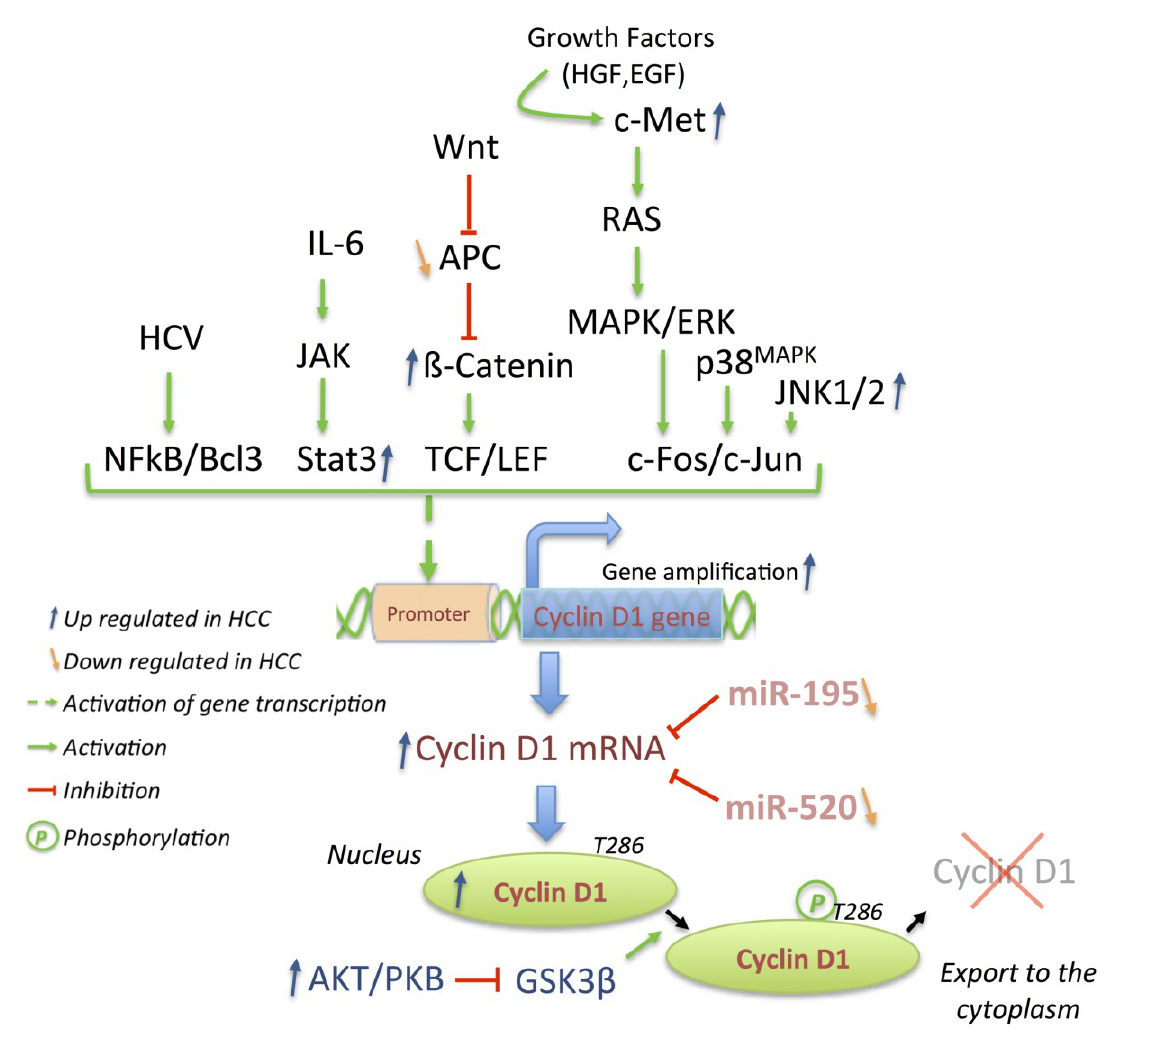
Figure 5. Cyclin D1 gene expression integrates mitogenic signals as well as their